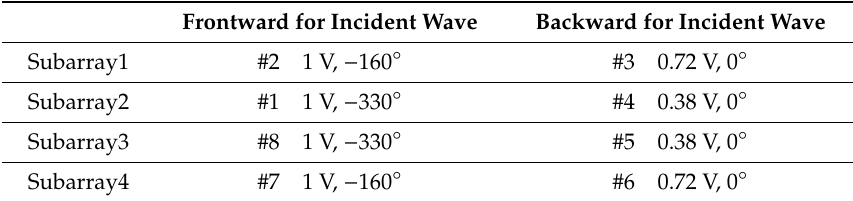
Table 1. Excitation conditions of each element